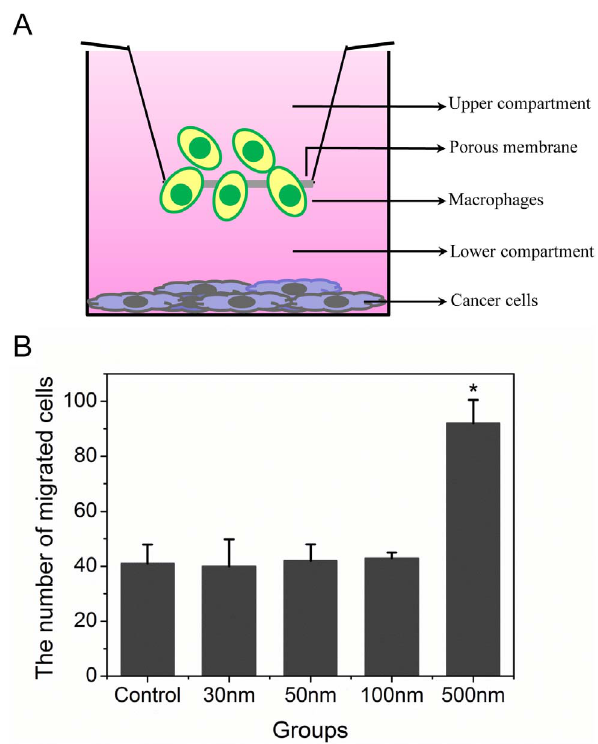
Figure 1. RAW 264.7 cells migration with or without uptake of varisized NPs. A) Schematic description of the Boyden chamber assay. RAW 264.7 cells were added to the upper chamber of the Boyden chamber and allowed to migrate through the porous membrane into the lower chamber containing medium alone or medium with MDA- MB231. Cells were pretreated with culture medium or varisized NPs. B) Migrated cells on the lower side of the membrane were stained with Hoechst 33342 and counted under a fluorescence microscope using a 6 20 objective. The histogram illustrates the number of migrated cells in different treatment. * p , 0.05 compared with control (Error bar is